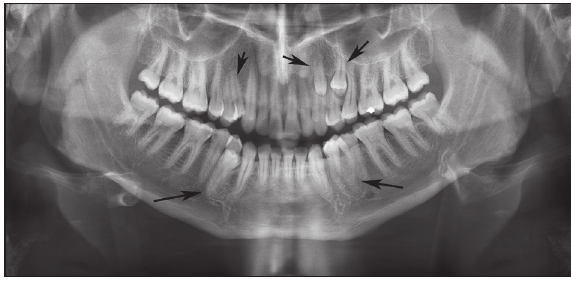
Figure 3. Panoramic radiograph of patient aged 25 years (case 11). This patient has two supernumerary premolars in the mandible and three in the maxilla (arrows).